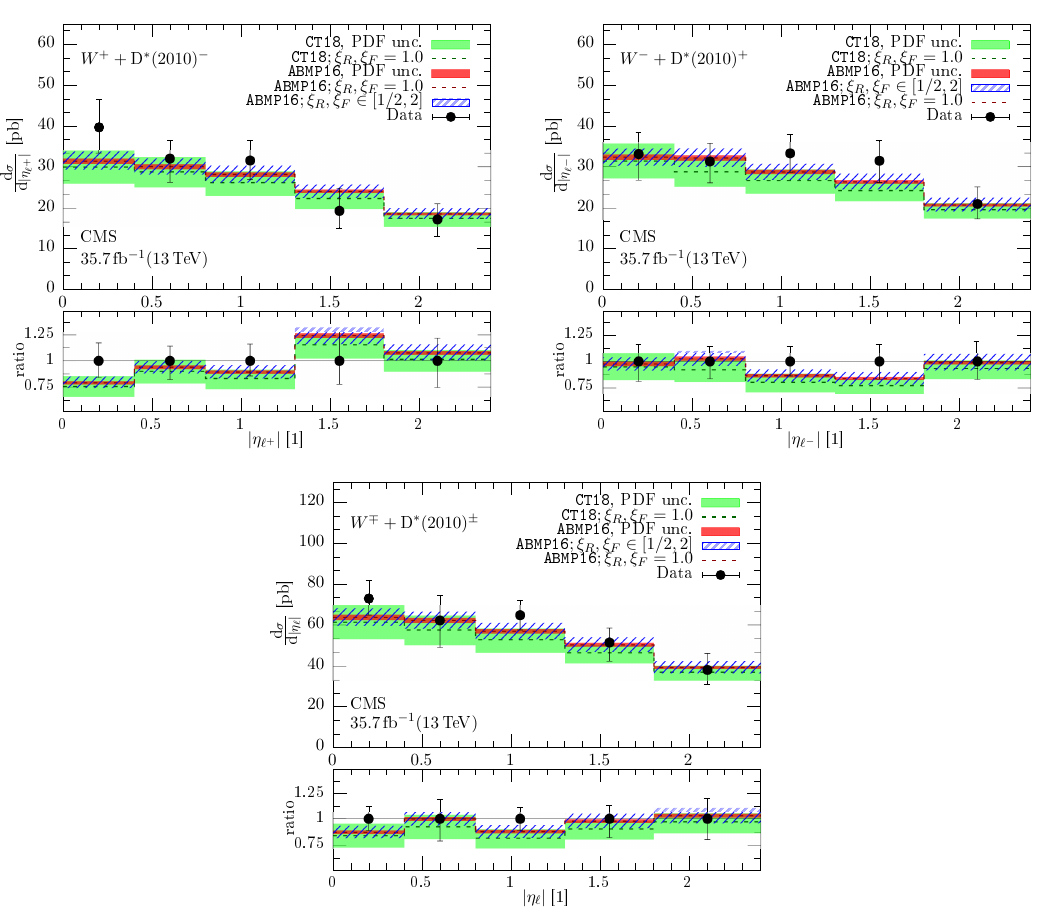
Figure 6 . Same as figure 3, but using the CT18NLO PDF set, with 2-loop α S evolution and α S ( M Z ) n f =5 = 0 . 118 consistent with the PDF set, and with m c = 1 . 4 GeV. Asymmetric PDF uncertainty bands (green solid), computed at 90% C.L. corresponding to the tolerance criterion adopted in this PDF fit, refer to this configuration. Predictions from this configuration are compared to those using the ABMP16_3_NLO PDF set, with 2-loop α S evolution and α S ( M Z ) n f =3 = 0 . 1066 ( α S ( M Z ) n f =5 = 0 . 1191 ), consistent with the PDF set, and with m c = 1 . 5 GeV. For the latter, beside PDF uncertainty bands (red solid) computed at 68% C.L. as customary for this PDF fit, we also report scale uncertainties (blue hatched